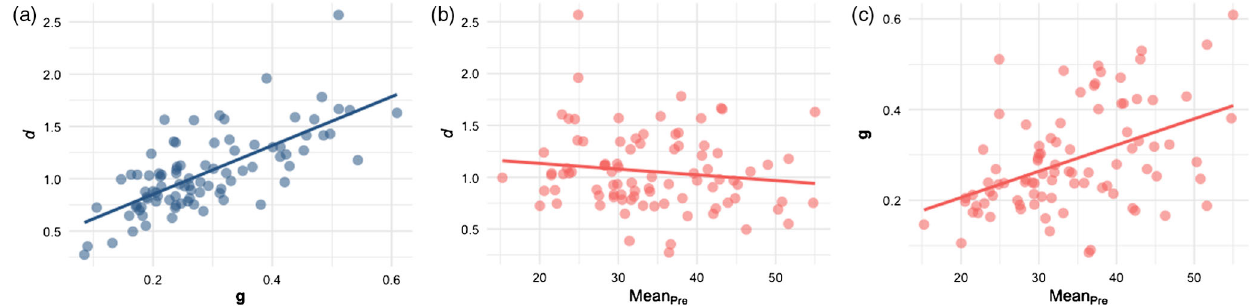
FIG. 2. Scatter plots for (a) d and g , (b) d and pretest mean, and (c) g and